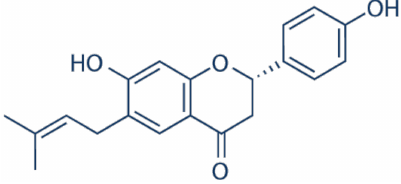
Figure 19. The chemical structure of bavachin.